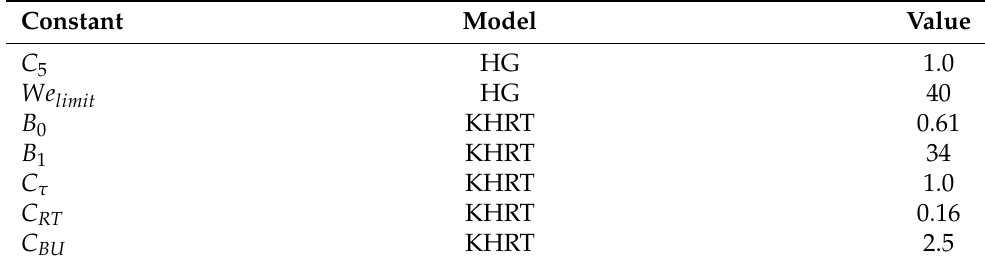
Table 1. Spray model